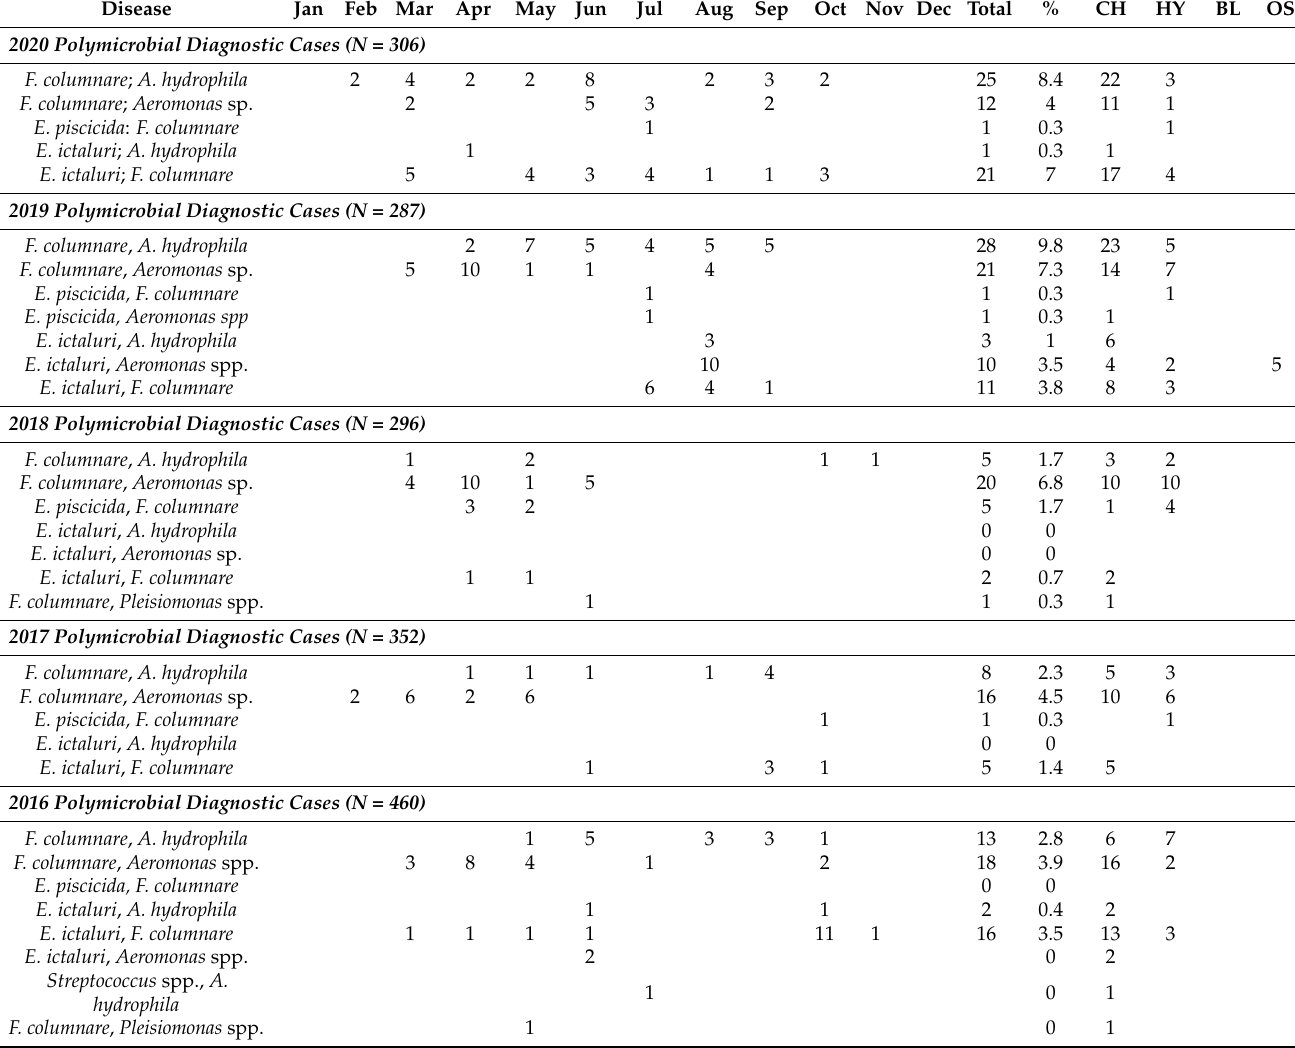
Table 4. Alabama Fish Farming Center polymicrobial cases from 2016 to 2020. Disease diagnosis as a percentage of